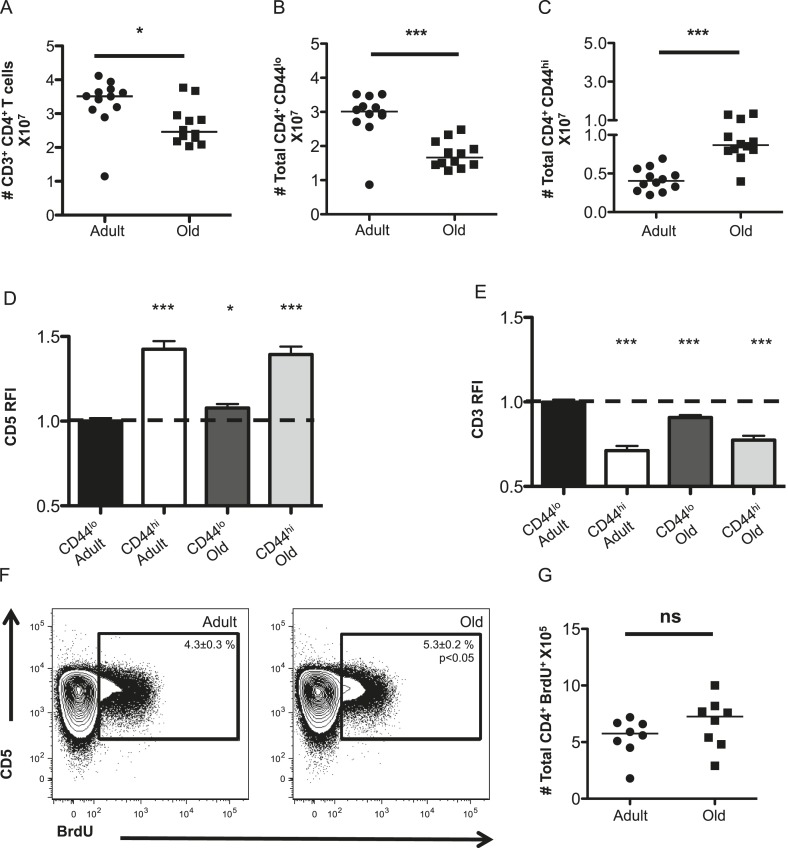
The CD4+ T-cell compartment contracts but accumulates CD44hiCD5hi cells with aging.The absolute numbers of T-cells in unprimed adult (8–12 weeks) and old (18–22 months) mice are shown as (A) total CD4+ T-cells in secondary lymphoid organs, (B) CD4+ CD44lo (naïve) T-cells and (C) CD4+ CD44hi (memory phenotype) T-cells. Data are concatenated from three experiments, 4 mice/group. Horizontal bar indicates median (*p < 0.05, ***p < 0.0001; Mann–Whitney). (D) Relative fluorescent intensity (RFI) of CD5 expression on adult and old CD44hi and CD44lo CD4+ T-cells relative to CD5 expression on adult CD44lo CD4+ T-cells (dotted line). Data represent four experiments with 4 mice/group (***p < 0.0001, *p < 0.05; Mann–Whitney). (E) RFI of CD3 expression on adult and old CD44hi and CD44lo CD4+ T-cells relative to CD3 expression on adult CD44lo CD4+ T-cells (dotted line) (***p < 0.0001; Mann–Whitney). Results represent seven experiments with 4 mice/group. (F) Concatenated contour plots (4 mice) showing CD5 vs BrdU incorporation in unprimed adult and old total CD4+ T-cells. Percent BrdU+ of total CD4+ T-cells ± SEM is shown in the inset (*p < 0.05 Mann–Whitney adult compared to old). (G) Absolute numbers of CD4+ BrdU+ T-cells. Results are representative of two experiments with 4 mice/group.